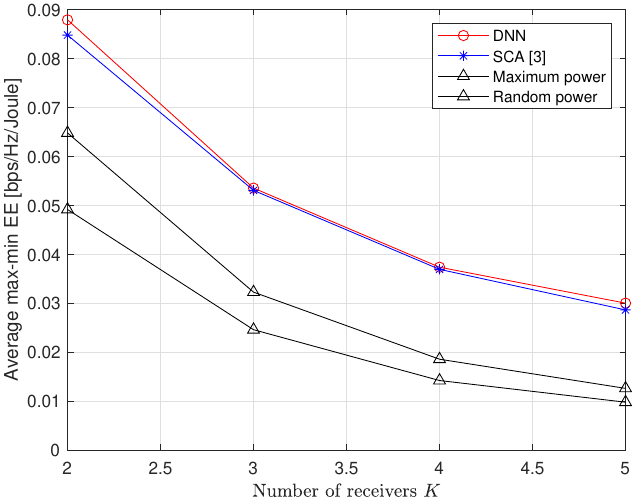
Figure 8. Average max-min EE performance as a function of K for P = 30 dBm and P C = 33 dBm.